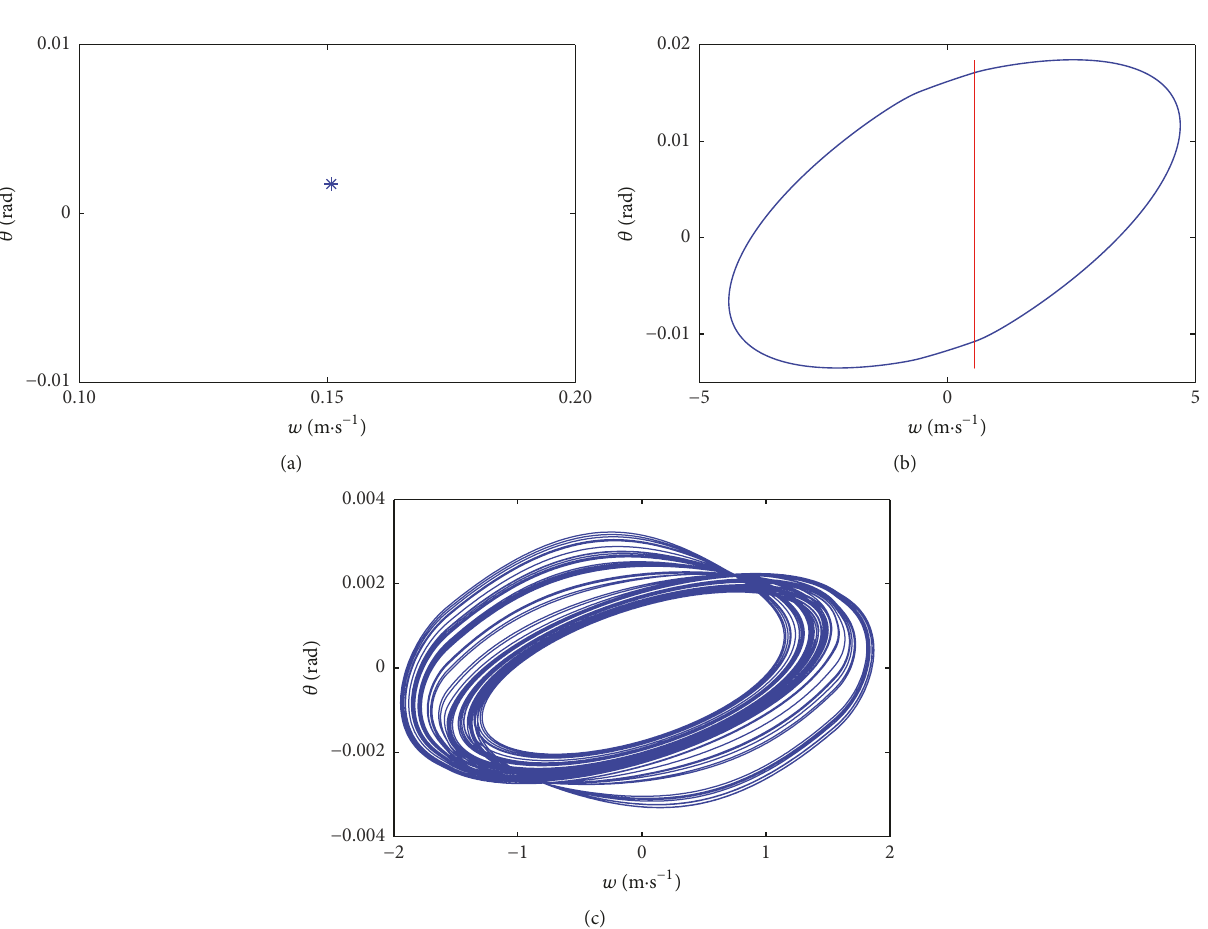
Figure 4: Phase tracks of three stable states on 𝑤 - 𝜃 plane: (a) 𝜎 = 0.02249 , 𝑘 = −14.05 ; (b) 𝜎 = 0.03459 , 𝑘 = −1.75 ; (c) 𝜎 = 0.03040 , 𝑘 = −59.13